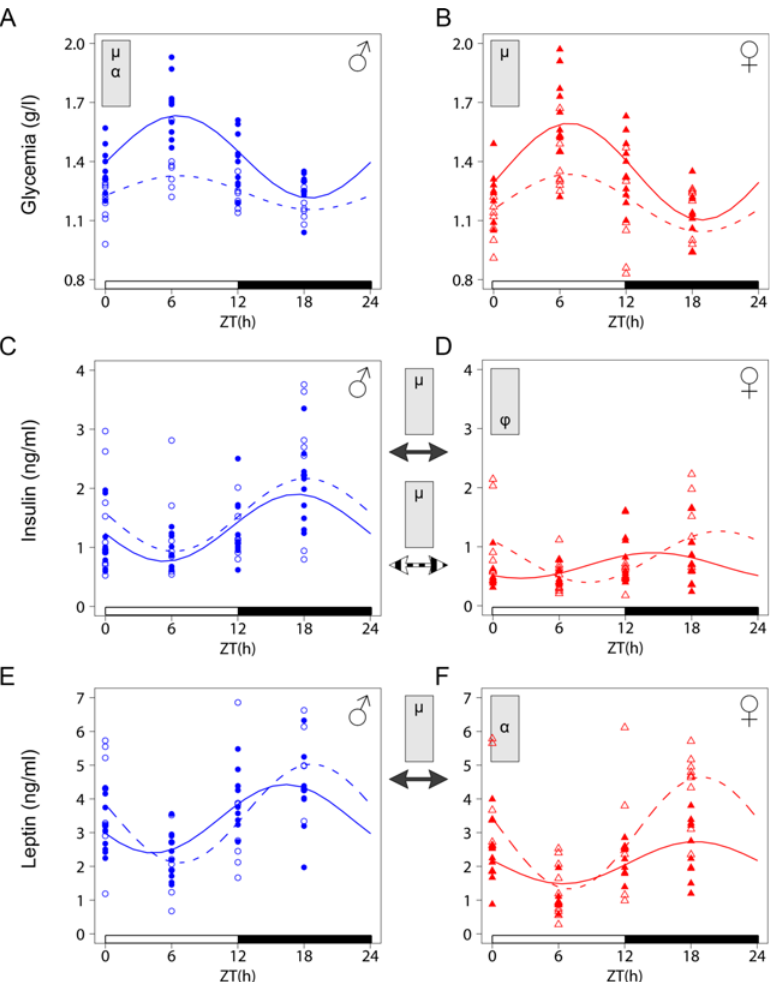
cycle. Cosinor-based non-linear regression was used for curve fitting. The ZT0 time point is double plotted for visualization purposes. The white and black bars represent the light and dark phases, respectively. Statistically significant differences in cosine fitting parameters (p < 0.05) between wild type and Lxr α -/- mice or between male and female of the same genotype is indicated in the grey box at the top of the corresponding graph or between graphs (WT: plain arrow, Lxr α -/- : dashed arrow). μ , α and φ indicate a difference in mean level, amplitude and acrophase,